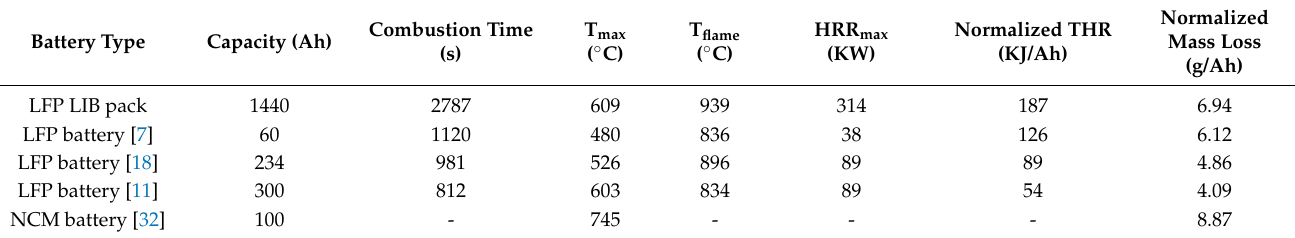
Table 2. Combustion hazards of